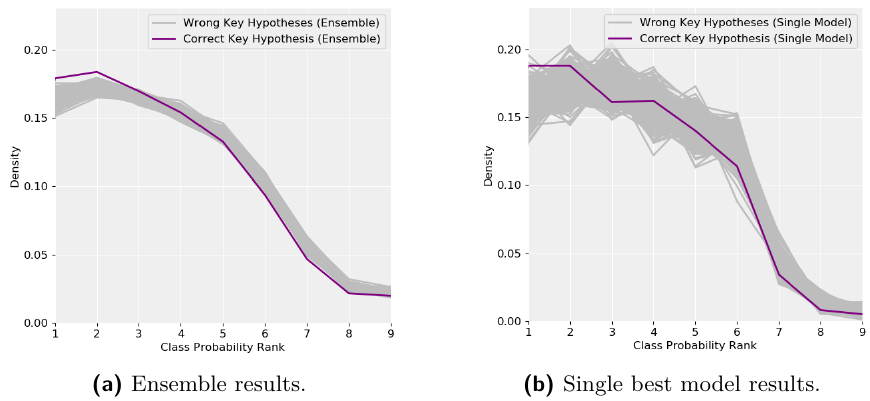
Figure 7: Rank of output class probabilities computed from the CHES CTF 2018 dataset. Ensemble of 50 models.